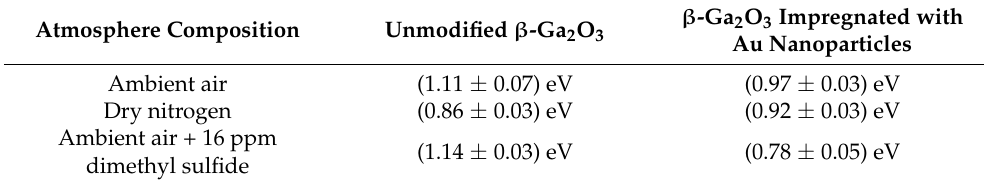
Table 2. The value of the activation energy E a of β -Ga 2 O 3 layers in various